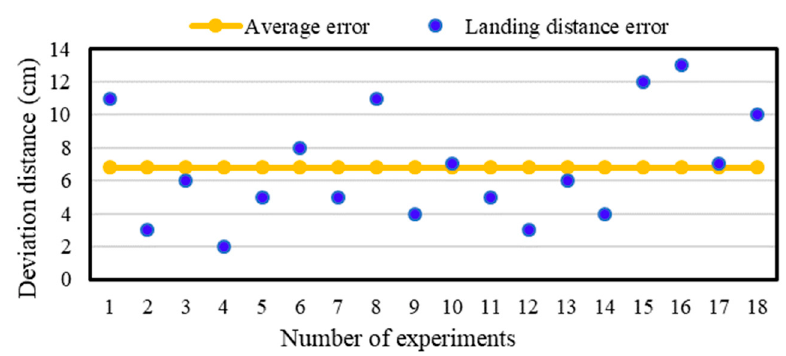
Figure 9. The error distribution of fixed-point landing. Horizontal axis is the number of experiments. Vertical axis is the distance from the center of the UAV landing position to the center of the image label. Blue dot is the distance error. Orange dot is the average error.